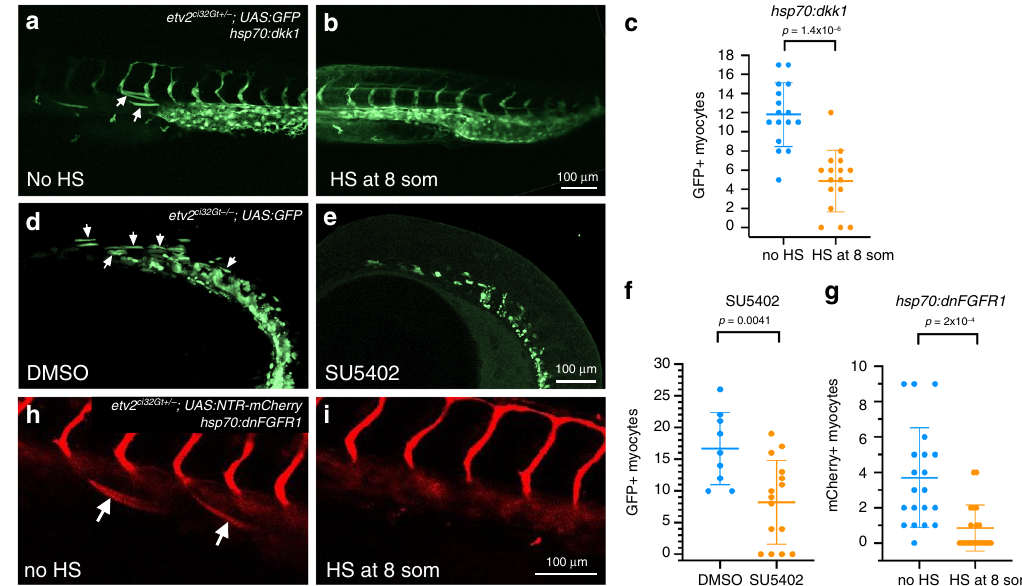
Fig. 6 Wnt and FGF signaling is required for differentiation of etv2 ci32Gt ; UAS:GFP cells into skeletal muscle. a – c Heat-shock inducible expression of Wnt inhibitor Dkk1 greatly reduces GFP-positive muscle cells in hsp70:dkk1; etv2 ci32Gt + / − ; UAS:GFP embryos. Heat-shock (HS) was performed at the 8- somite stage, and GFP fl uorescence imaged at 24 – 26 hpf. Sixteen embryos were analyzed in each group in two replicate experiments. d – f etv2 ci32Gt − / − ; UAS:GFP embryos treated with FGF inhibitor SU5402 starting at the 50% epiboly stage show a greatly reduced number of GFP-positive cells at the 22-somite stage. Nine control DMSO-treated and 15 SU5402-treated embryos were analyzed in two replicate experiments. g – i Heat-shock inducible expression of dnFGFR1 results in a signi fi cant reduction of mCherry-positive muscle cells in etv2 ci32Gt + / − ; UAS:NTR-mCherry; hsp70:dnFGFR1 embryos. Twenty each control and HS hsp70:dnFGFR1 embryos were analyzed in two replicate experiments. Median ± SD values are shown in all graphs, two-tailed Student ’ s t test was used for statistical cells was not affected in FGF-inhibited etv2 ci32Gt + / − embryos dnFGFR1 was induced at the 8-somite stage. A signi fi cant reduction in the number of ectopic muscle cells was observed in FGF-inhibited (Supplementary Fig. 14c). Together, these results suggest that FGF embryos while no signi fi cant defects in vascular development were signaling is required for muscle-speci fi c differentiation of multi- apparent (Fig. 6g – i). The overall number of UAS reporter-positive potent etv2 + progenitors.